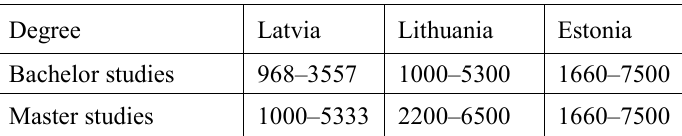
Table 1. Average Tuition Fee in the Baltic States (EUR)